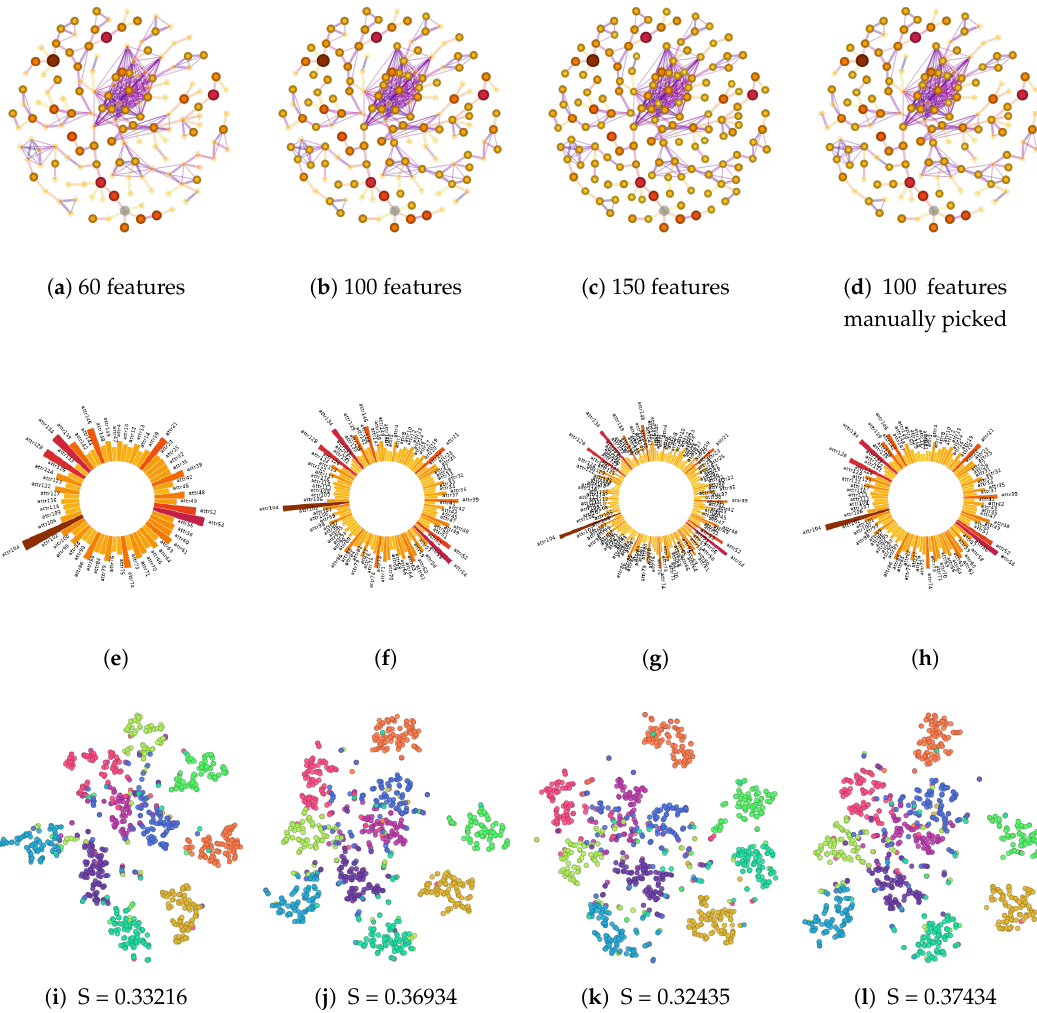
Figure 8. Corel 1k dataset with 10 classes. ( a – c ) Minimum spanning trees with with an increasingly larger set of features selected by ranked relevance. ( d ) Minimum spanning tree with manually selected features, based on the information provided by graph edges and neighborhoods. ( e – h ) Radial histograms of the selected features. ( i – l ) t-SNE projection for the 1000 data instances subject to the selected features space, and silhouette